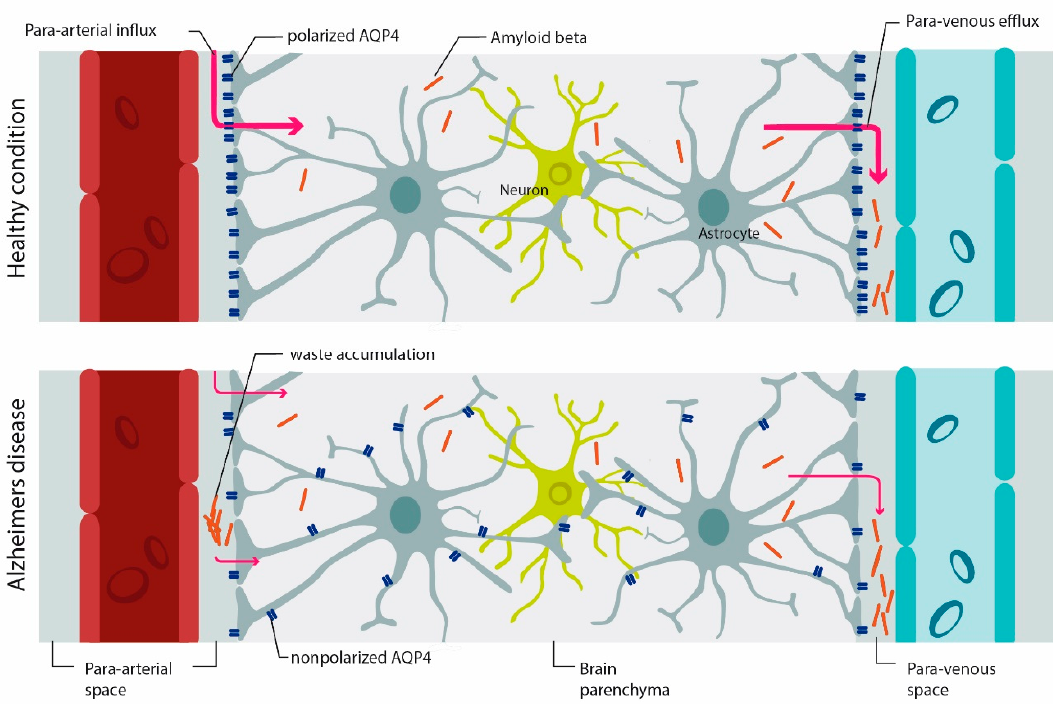
Figure 2. AQP4 mediates-waste clearance through the glymphatic system. In the healthy brain, AQP4 is mainly expressed on astrocyte endfeet (polarized AQP4 expression). CSF circulates through the para-arterial system (para-arterial influx) into the brain parenchyma and then into the veins (para-arterial efflux). With aging, and even more so under pathologic conditions, AQP4 polarization is reduced and there is more expression of AQP4 on parenchymal processes (AQP4 depolarization), which affects the efficiency of the glymphatic system in waste clearance such as beta-amyloid. Accumulation of beta-amyloid is a hallmark of AD [98]. Image modified from [100,101].